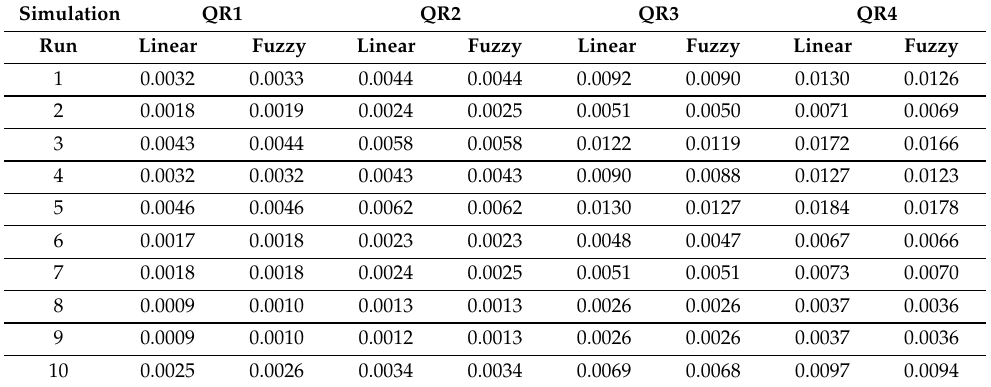
Table 4. Results of J T for 10 simulations.